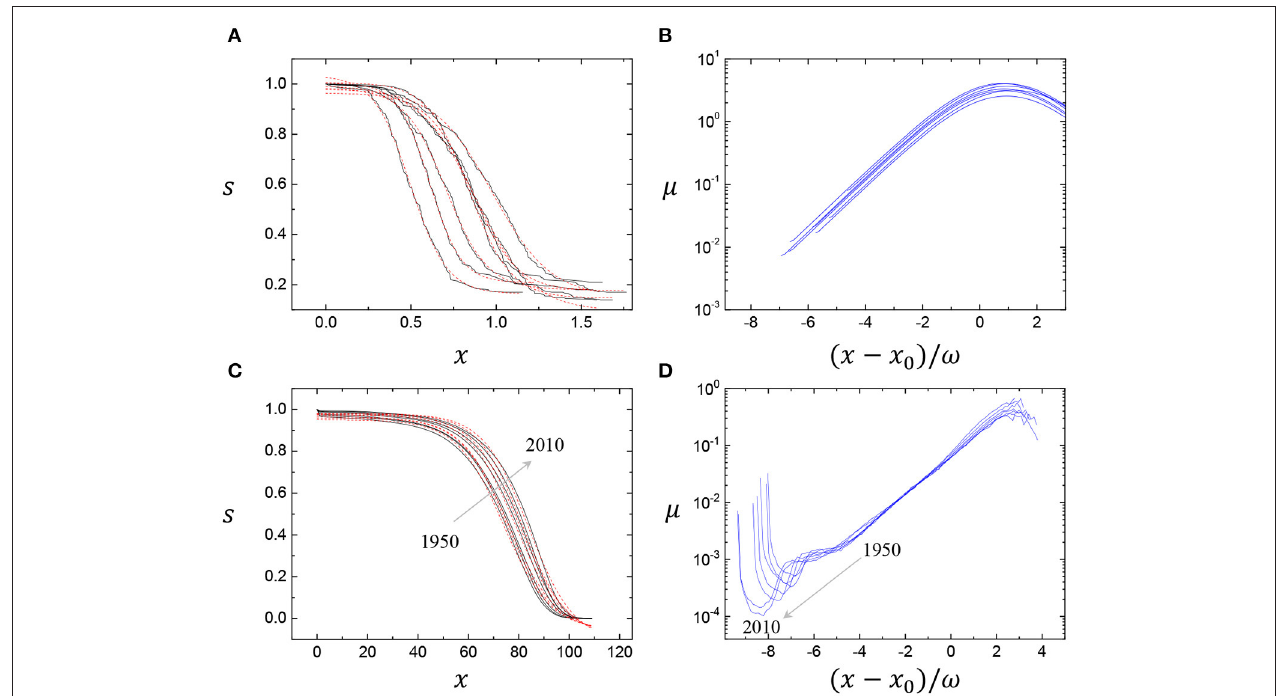
FIGURE 3 | Gompertz mortality patterns for clean foams (A,B) and for humans (C,D) . The clean foam coalescence data were analyzed for the Dataset 2 (reproduced by Dr. Peter Stewart). The human survival and mortality data were taken for the USA female period life tables from 1950 to 2010 from the Human